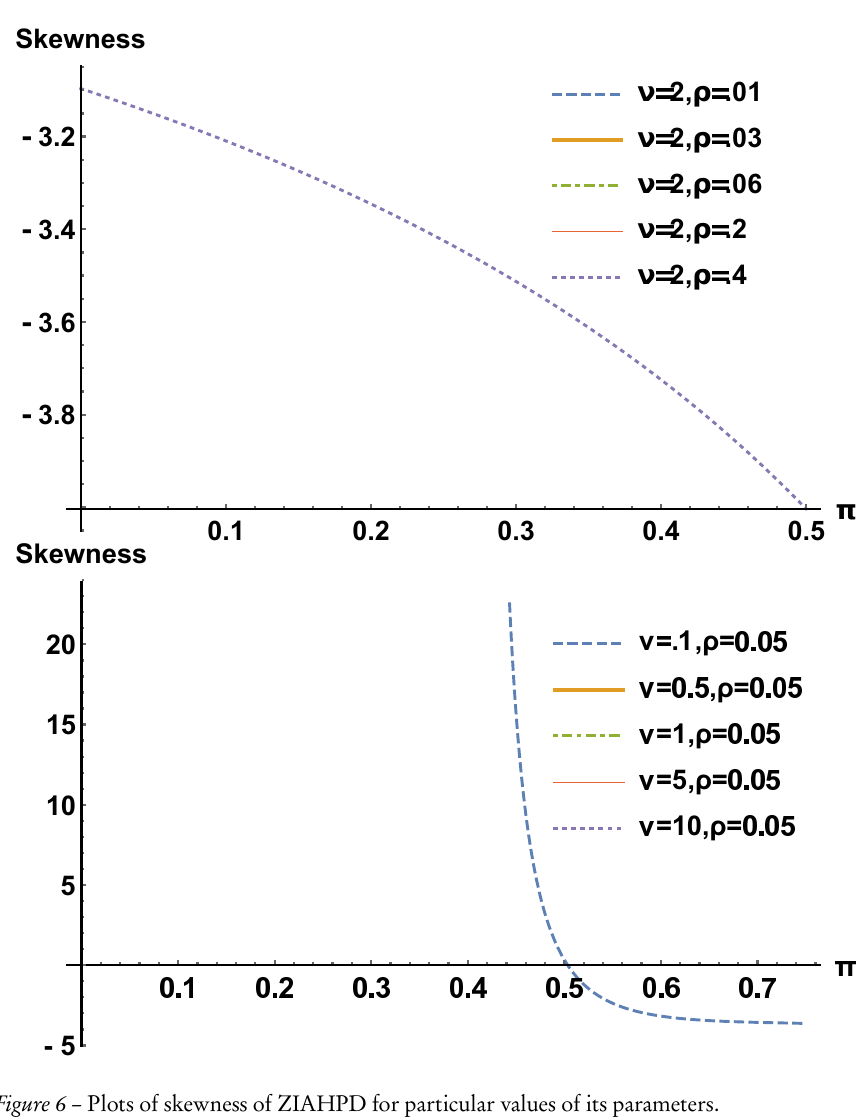
Also, from (17) we